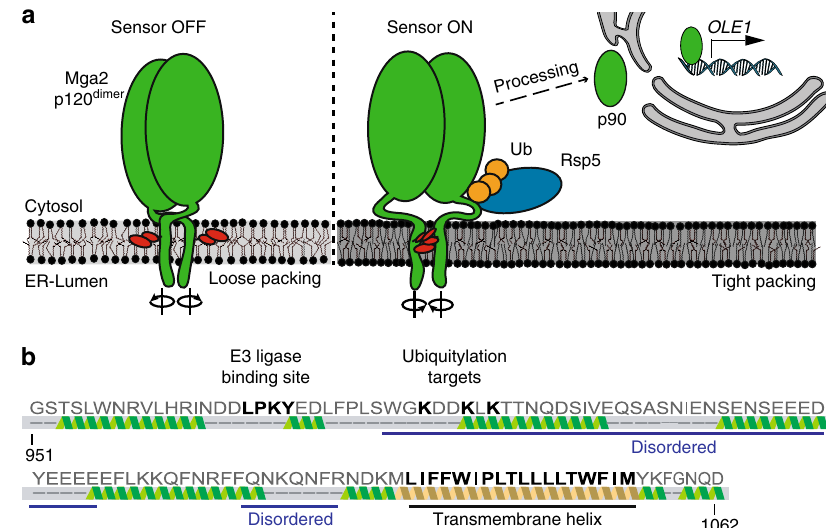
Fig. 1 The activation of Mga2 is controlled by the ER membrane composition. a Model of the OLE pathway: the transcription factor Mga2 forms inactive dimers in the ER membrane (Mga2 p120 dimer ) with highly dynamic TMHs exploring alternative rotational orientations. Loose lipid packing (left) caused by unsaturated lipids stabilizes conformations with two sensory tryptophan residues (W1042; red) pointing away from the dimer interface toward the lipid environment. Tight lipid packing (right) stabilizes alternative rotational conformations with the sensory tryptophans facing each other in the dimer interface (right). The E3 ubiquitin ligase Rsp5 is required to ubiquitylate (Ub) Mga2, thereby facilitating the proteolytic processing by the proteasome and the release of transcriptionally active Mga2 (p90). b Secondary structure prediction of the juxtamembrane and transmembrane region (residue 951 – 1062) of Mga2 using Phyre2 65 . Source data are provided as a Source Data fi